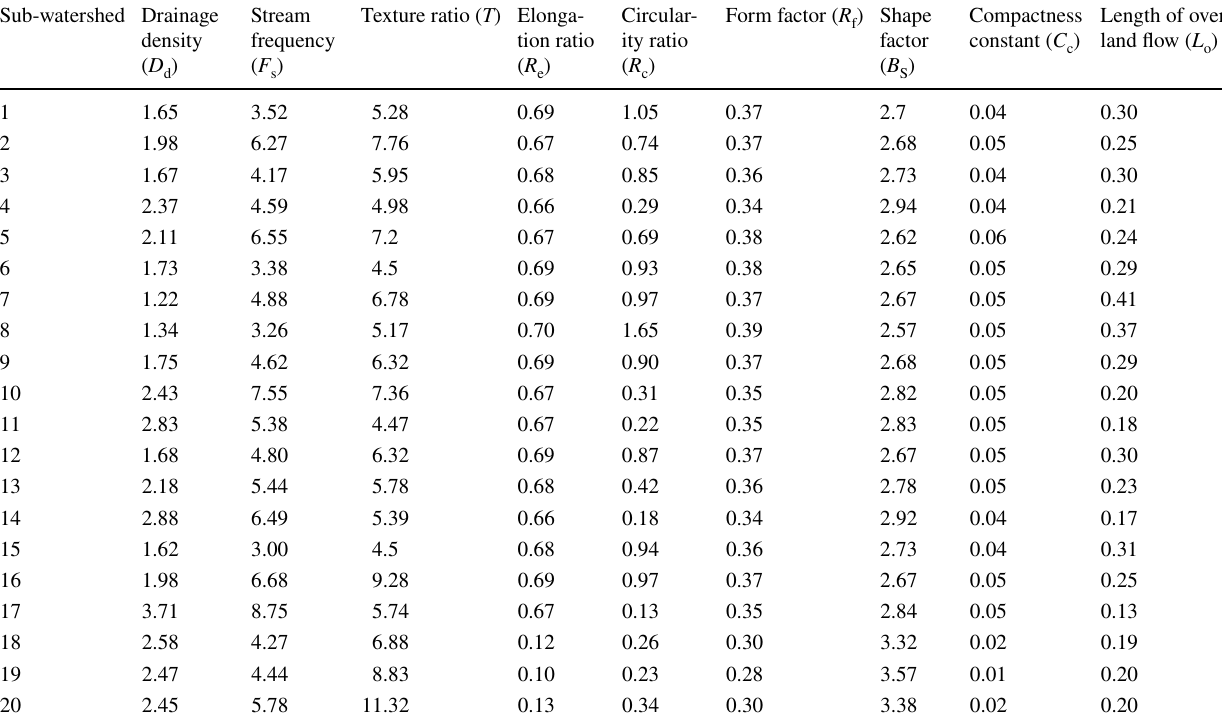
Table 5 Aerial aspect parameters value of watersheds Sub-watershed Drainage